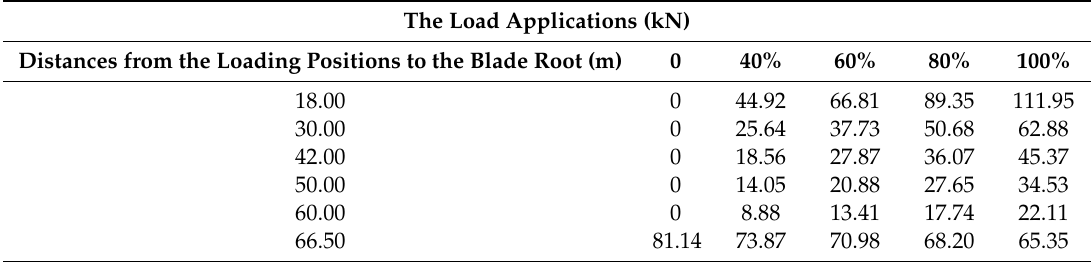
Table 3. The applied load of each stage when loaded on edgewise + .